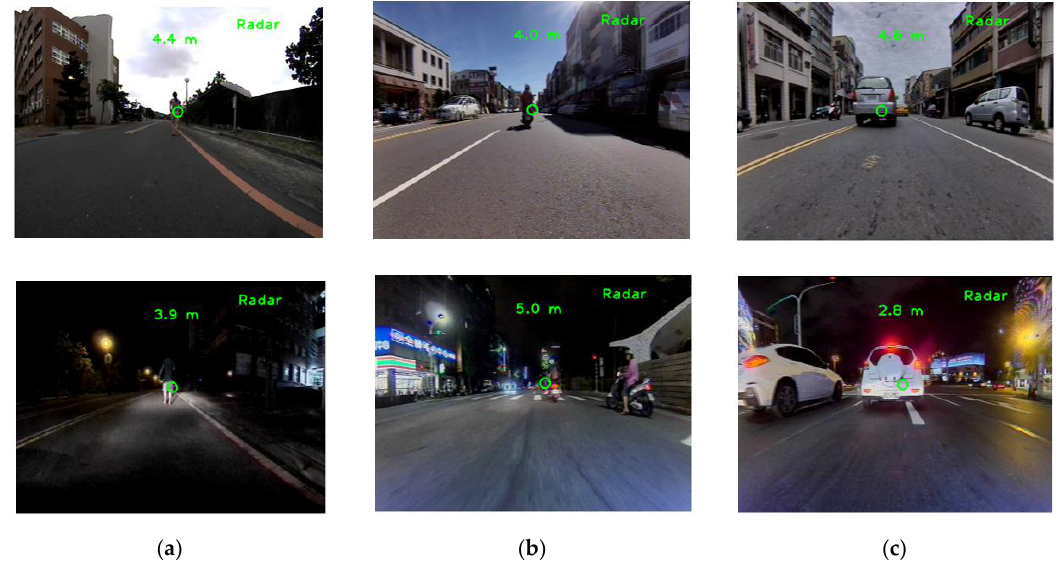
Figure 15. Detection results of radar subsystem, upper row: daytime, lower row: nighttime ( a ) a pedestrian, ( b ) motorcycle, and ( c ) car.